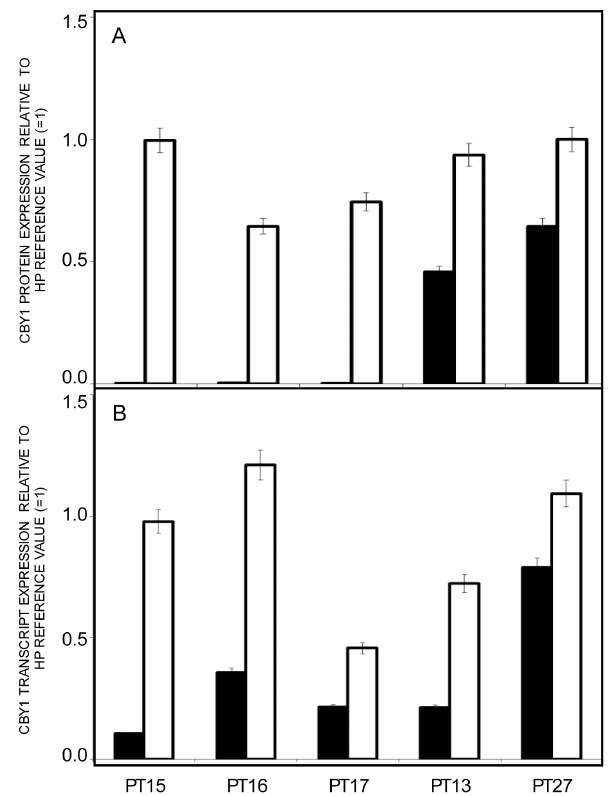
Figure 3. Cby1 reduced expression in MCF of CML-CP patients is restricted to the leukemic clone. At the moment of MMR Cby1 protein ( A ) and transcript ( B ) were significantly increased in all cases (p , 0.05 or less) and approached the HP levels in 3 cases (see Table S3 for signal intensity details and Figure S2 for blots). The levels of Cby1 protein and transcript were evaluated in MCF from bone marrow samples of 5 CML-CP patients at diagnosis (black columns) and at the moment of MMR under TK inhibitor therapy (white columns). At this instance, a 3-log reduction in BCR-ABL1 transcripts compared to diagnosis was seen (data not shown). Cby1 expression was expressed as described in the legend to Figure 2, with HP signal intensities used as reference